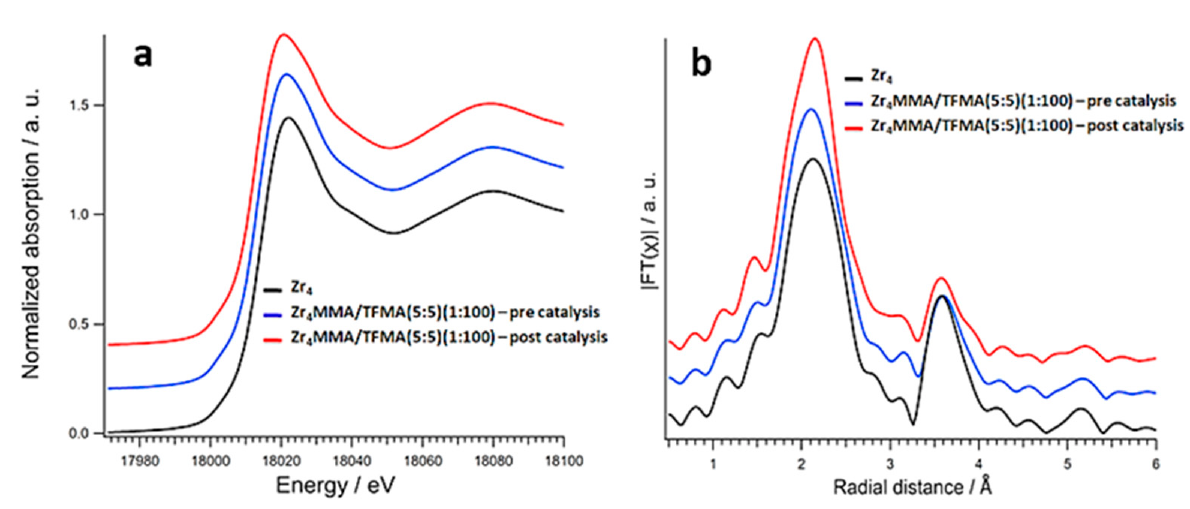
Figure 6. ( a ) Zr K-edge XANES spectra and ( b ) corresponding Fourier transforms of EXAFS curves of Zr4 oxocluster (black lines) and Zr4MMA/TFMA (5:5) (1:100) before (blue lines) and after (red lines) catalysis. Curves are shifted for clarity.